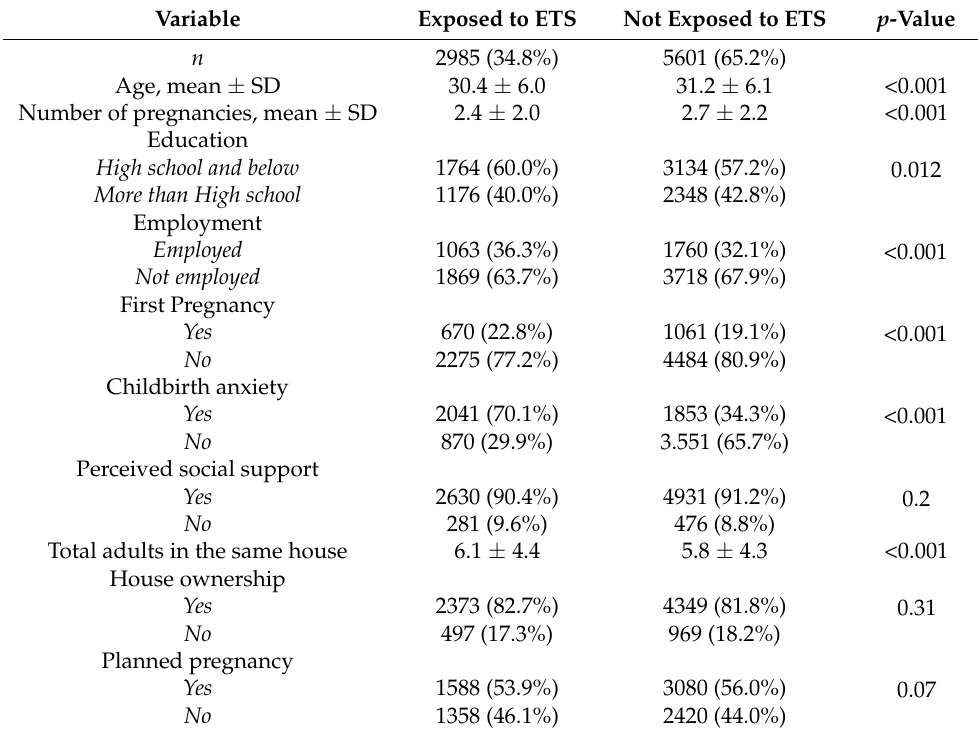
Table 1. Demographic characteristics of 8586 pregnant women stratified by their ETS exposure in Al Ain, UAE: The Mutaba’ah Study. Variable Exposed to ETS Not Exposed to ETS